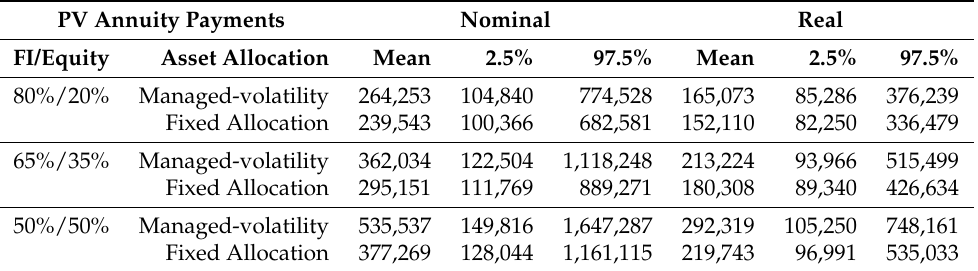
Table 10. PV Annuity Payments at Different Initial